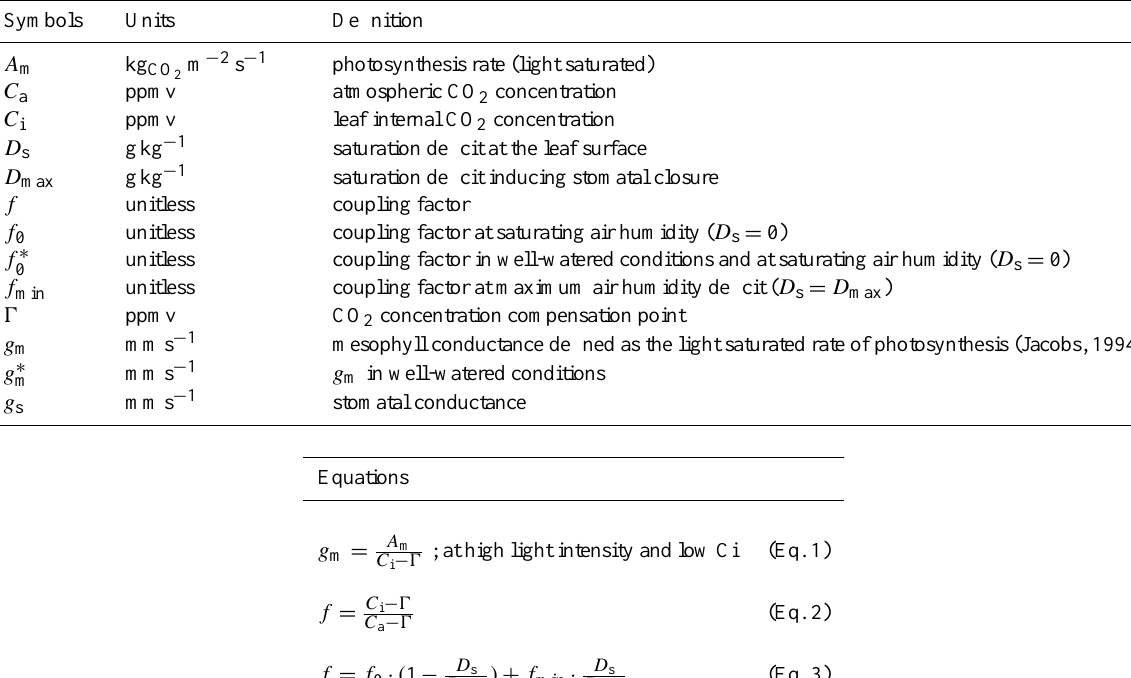
Table 1. ISBA CC : notation and main equations for the photosynthesis model.